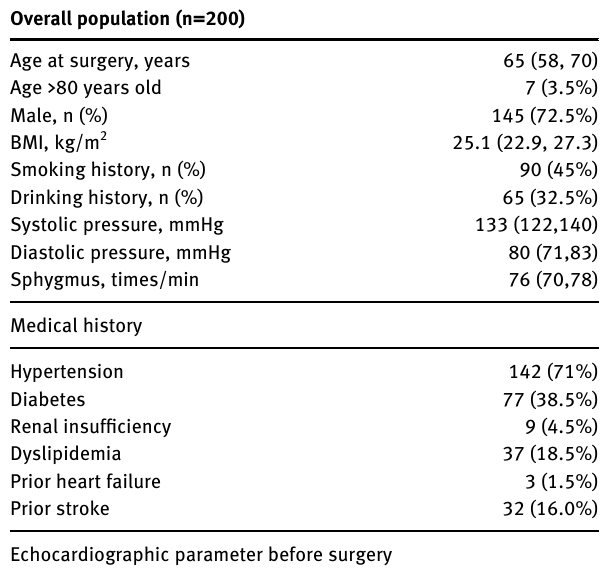
Table  : Preoperative baseline characteristics in patients under- going